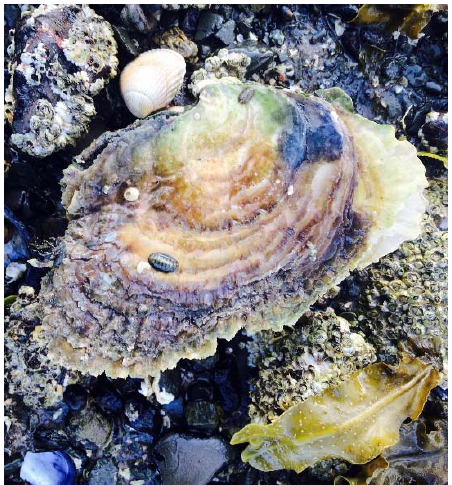
Figure 1. The native European oyster Ostrea edulis , Genus Ostrea (flat oysters) (Picture taken by Pogoda).